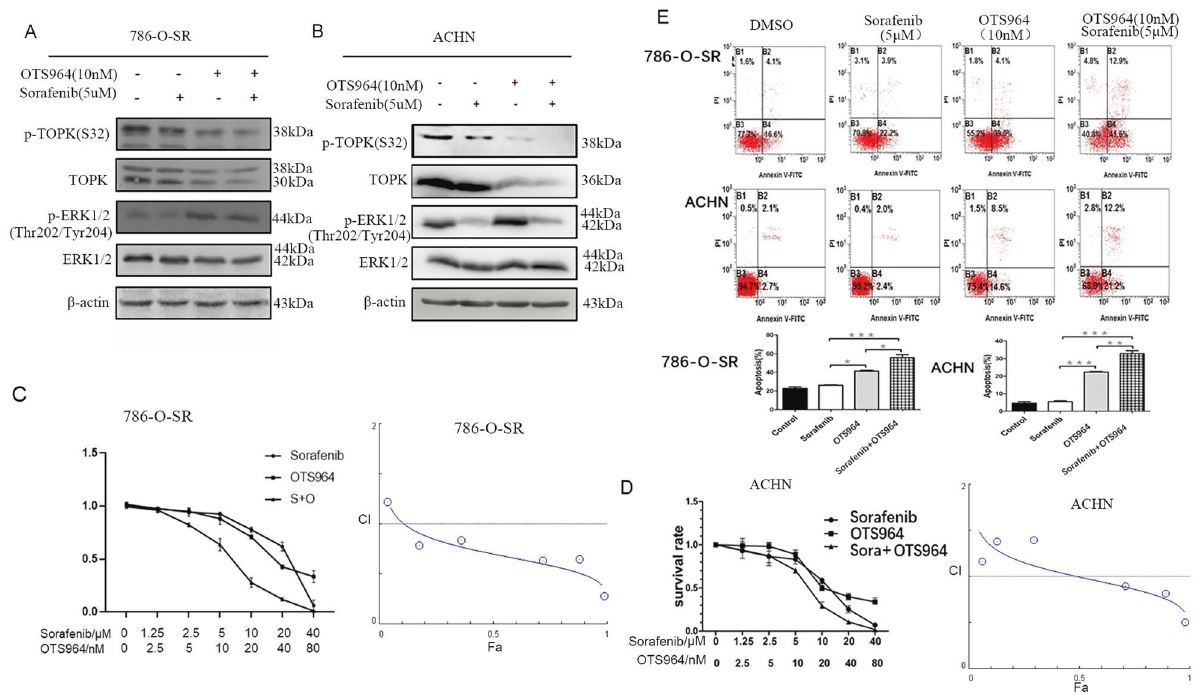
Fig. 5 The combination of sorafenib and TOPK inhibitor could promote the apoptosis of the sorafenib resistance RCC cells. A , B The sorafenib resistance RCC cell lines 786-O-SR and ACHN were incubated with sorafenib, OTS964, or a combination of sorafenib and OTS964 for 24 h. p-TOPK (S32), p-ERK1/2 (Thr202/Tyr204) were determined by western-blot after these cells were harvested. C , D The survival rate of every group was analyzed, and DPI of sorafenib and OTS964 was calculated. E The apoptosis of these cells was detected by fl ow cytometry. Data were represented as means ± SD of triplicate experiments. *, means P < 0.05, **, means P < 0.01.